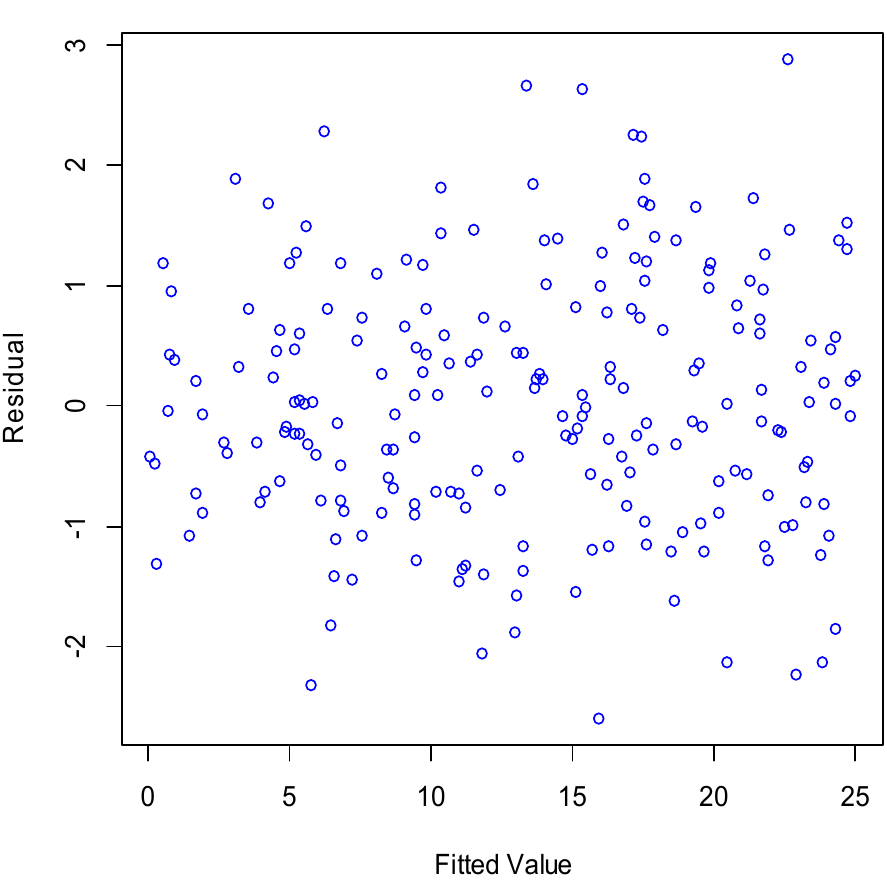
Figure 2. Plot of residuals versus the observation order for the BMLR model.